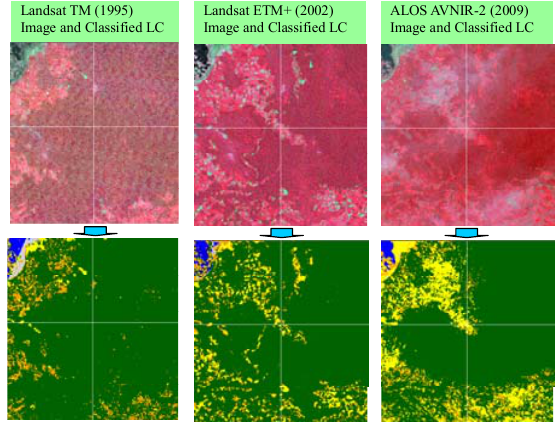
Figure 6. An Example of Land Cover Change (1995 to